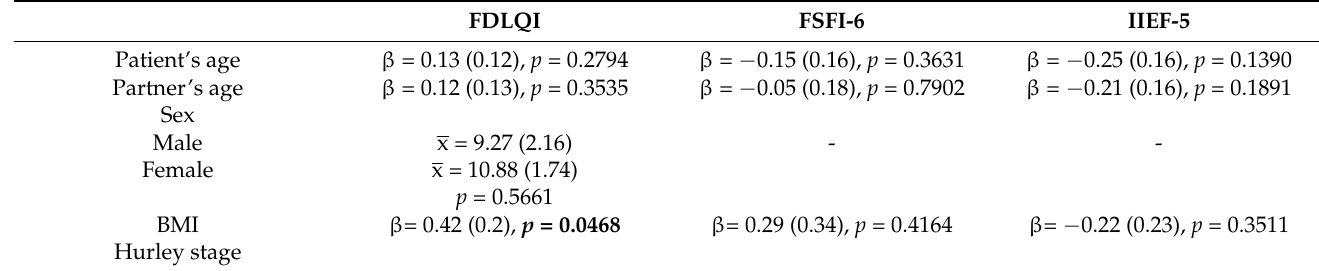
Table 4. Factors associated with lower FDLQI, FSFI-6 and IIEF-5 scores in patients’ partners. FDLQI